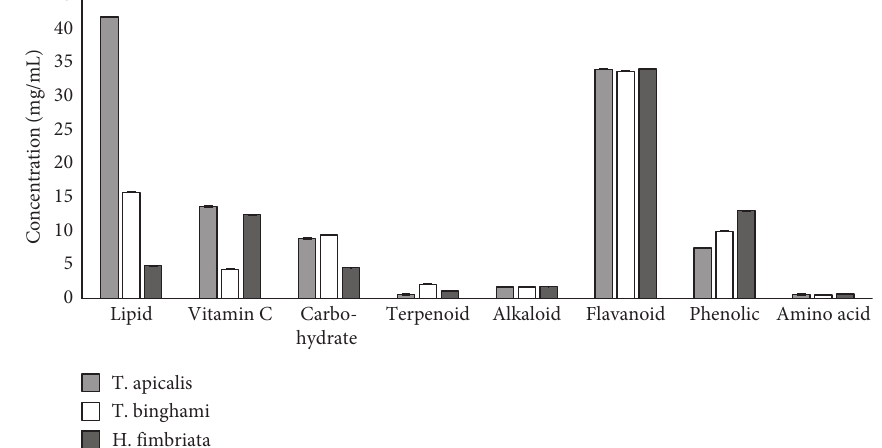
Figure 4: Comparison of detected compounds from GC-MS screening of T. apicalis , T. binghami , and H. fimbriata propolis water